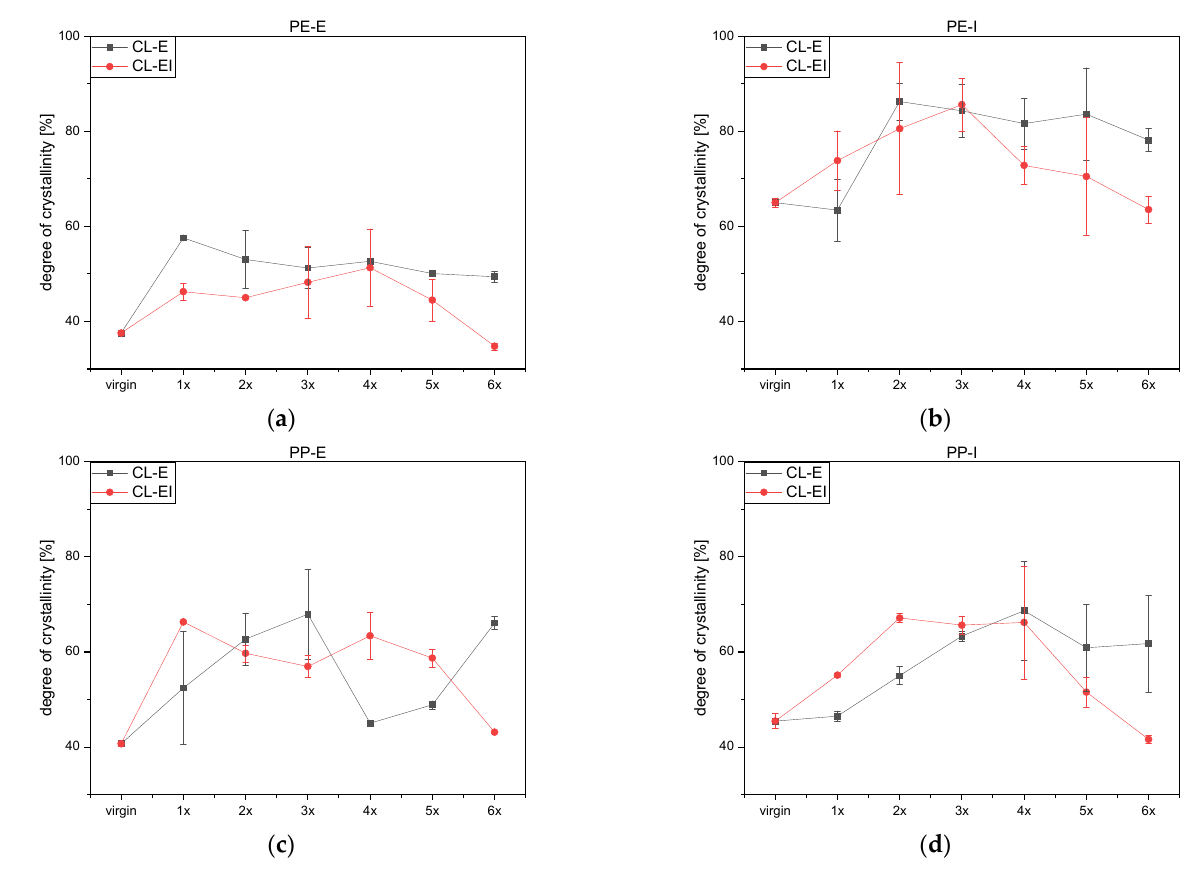
Figure 8. Calculated degrees of crystallinity after each loop for both cycles: ( a ) PE-E, ( b ) PE-I, ( c ) PP-E and ( d ) PP-I.